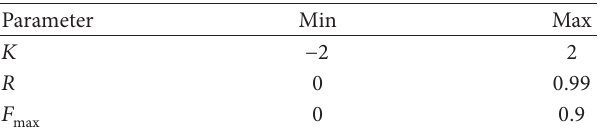
Table 1: Estimated parameters.